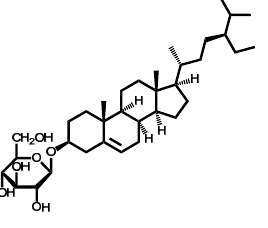
Figure 5. The structures of compounds (89–108) obtained from Cortex Periplocae .